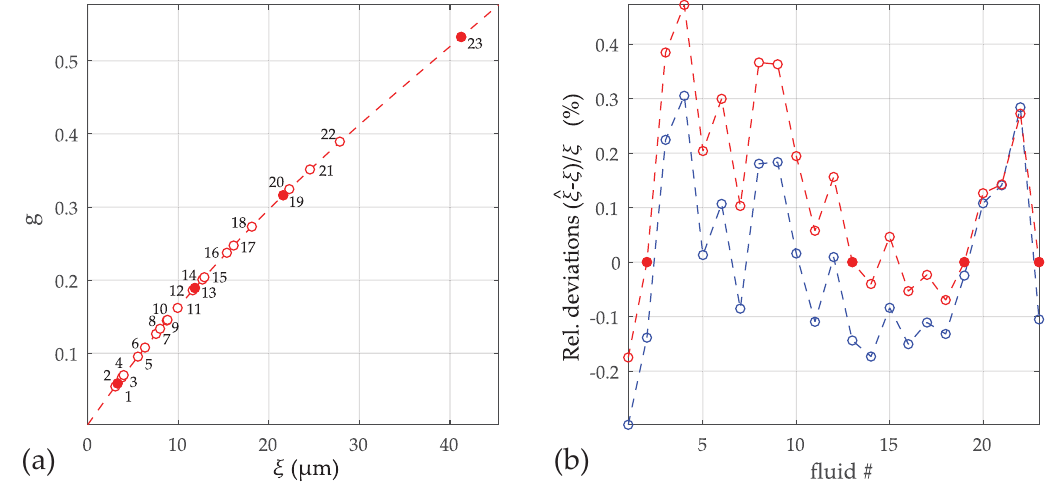
Figure 7. ( a ) Function g in Equation (24) for the liquids in Table 1. The fluids marked by the filled dots are used for estimating the constants c 1 . . . c 3 of a third order polynomial. ( b ) deviations between reference ( ξ ) and estimated values ˆ ξ . These curves result if only the selected (red) or all fluids (blue) are used for calibrating the four model constants.